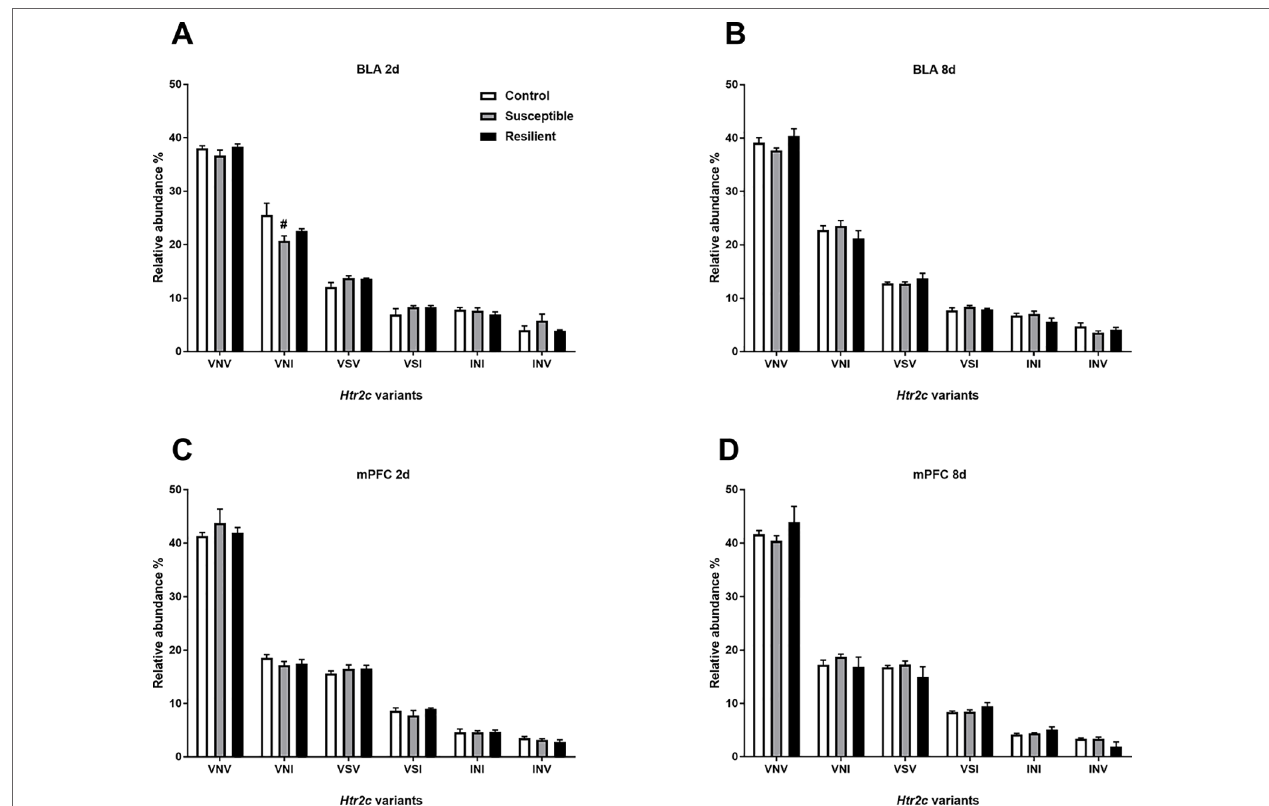
FIGURE 5 | Relative abundance of Htr2c variants is minimally altered within the BLA 2 days following CSDS. CSDS induced a nominally significant decrease of the VNI Htr2c transcript variant in the BLA of susceptible mice 2 days following CSDS (A) with no other changes observed at 8 days (B) or at 2 days (C) or 8 days within the mPFC (D) . Control 2 days, n = 6–8; susceptible 2 days, n = 10; resilient 2 days, n = 4; control 8 days, n = 7–8; susceptible 8 days, n = 7; resilient 8 days, n = 3. # p = 0.058, one-way ANOVA with Sidak post hoc